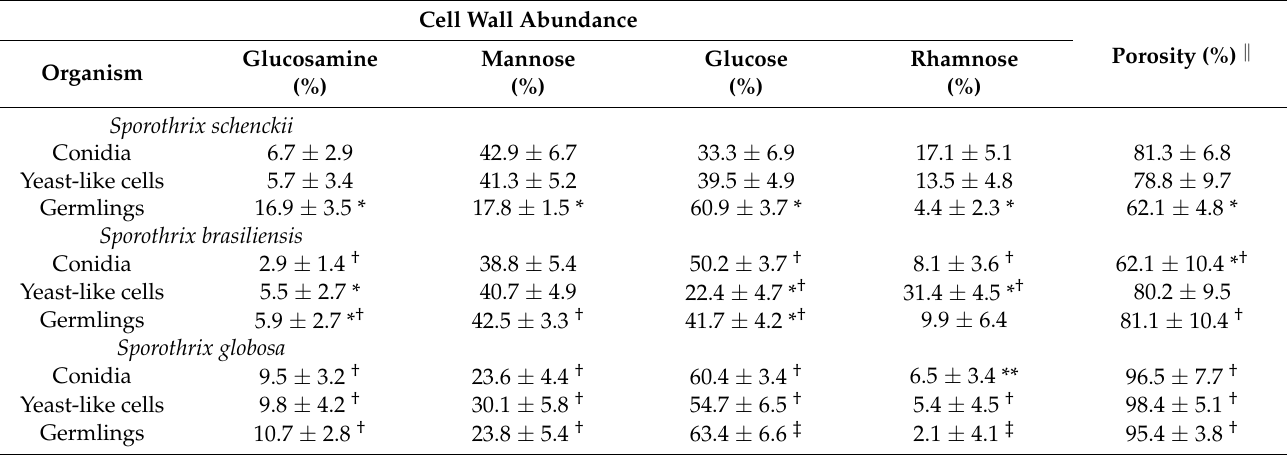
(cid:107) Relative to DEAE-dextran, the 100% corresponds to the poly-L-lysine porosity. * p < 0.05 when compared to other morphologies of the same species. † p < 0.05 when compared to the same morphology of the other two species. ** p < 0.05 when compared to the same morphology in Sporothrix schenckii. ‡ p < 0.05 when compared to the same morphology in Sporothrix brasiliensis.